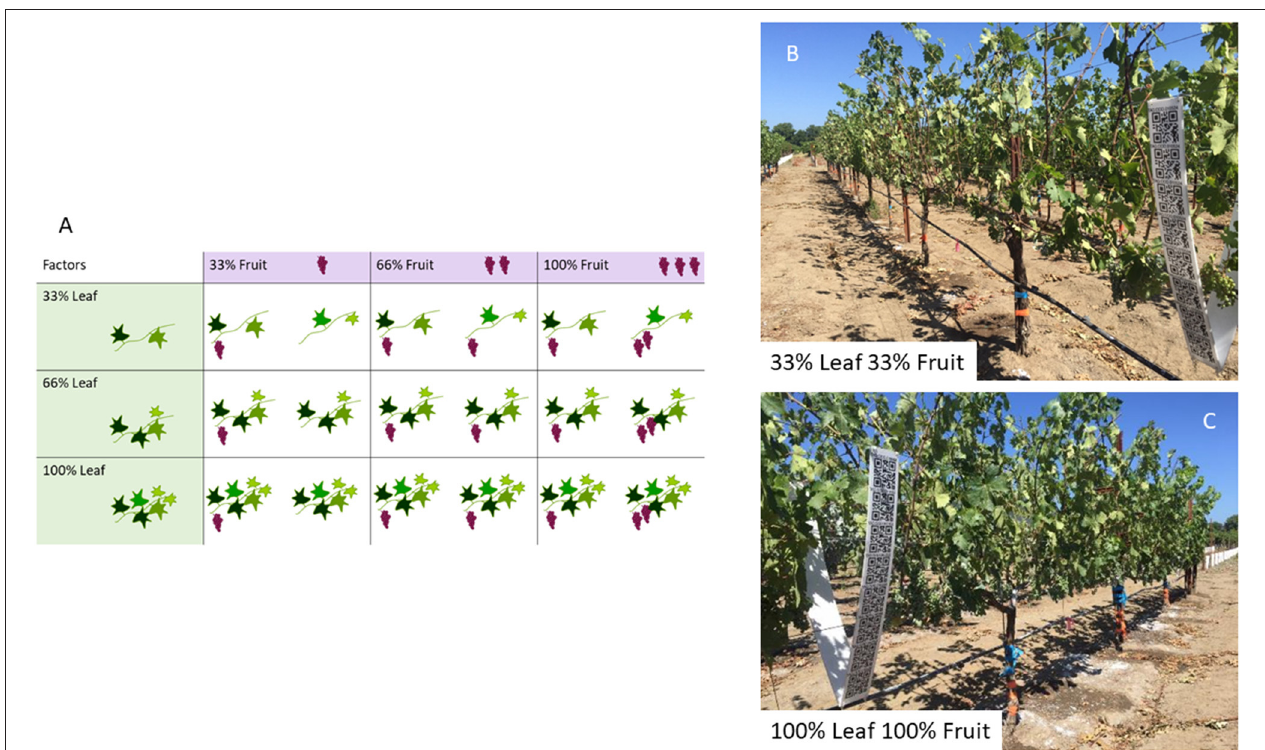
FIGURE 1 | Amount of defoliation and crop removal conducted to achieve the treatment levels desired in the experiment. Amount of defoliation and fruit removal conducted to achieve the treatment levels desired in the experiment (A) , most extreme defoliation and fruit removal treatment (B) and least extreme defoliation and fruit removal treatment (C)